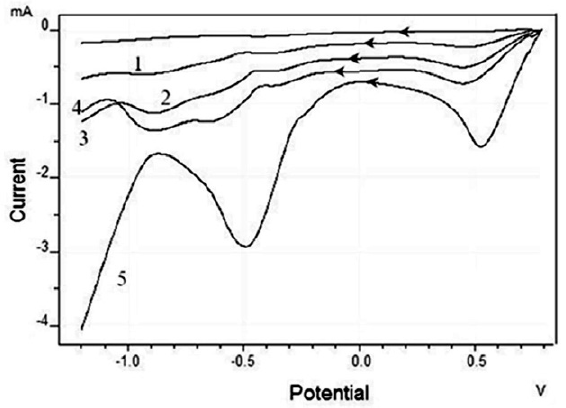
Fig. 4. The influence of the concentration of iron (III) ions on the electroreduction process on the Pt electrode. The electrolyte com- position in (M): Fe(NO 3 ) 3 · 9H 2 O + CH 2 OH-CH 2 OH; 1-0.005; 2- 0.05; 3- 0.1; 4- 0.15; 5- 0.2. At Т = 293 К, and Е V =0.02 V/s